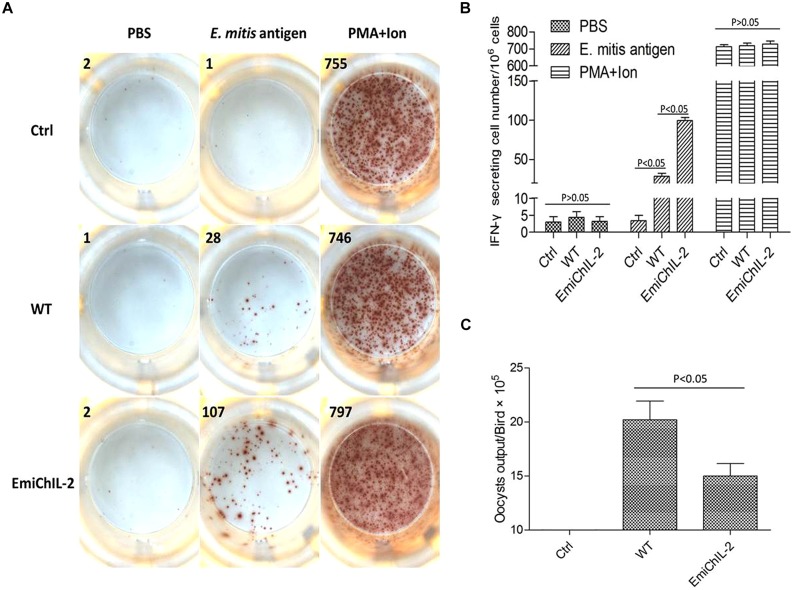
Gamma interferon (IFN-γ) secretion lymphocytes in peripheral blood mononuclear cells (PBMCs) after immunization. (A) 106 PBMCs from PBS (Ctrl, upper), wild-type E. mitis (middle) and EmiChIL-2 (bottom) immunized birds (104 oocysts/bird) were stimulated for 24 h with PBS (negative control, left), E. mitis oocysts antigen (middle) and PMA plus ionomycin (positive control, right). The number of IFN-γ secretion lymphocytes (spots) was determined as described in the section of materials and methods. (B) The mean amount of IFN-γ secretion lymphocytes in PBMCs in EmiChIL-2 immunized birds was significantly higher (p < 0.05) than that of the birds immunized with the wild-type E. mitis (n = 4). (C) Mean total oocyst output per chicken from 4 to 8 days after the immunization with EmiChIL-2 was much lower (p < 0.05) than after that, done with the wild-type E. mitis.